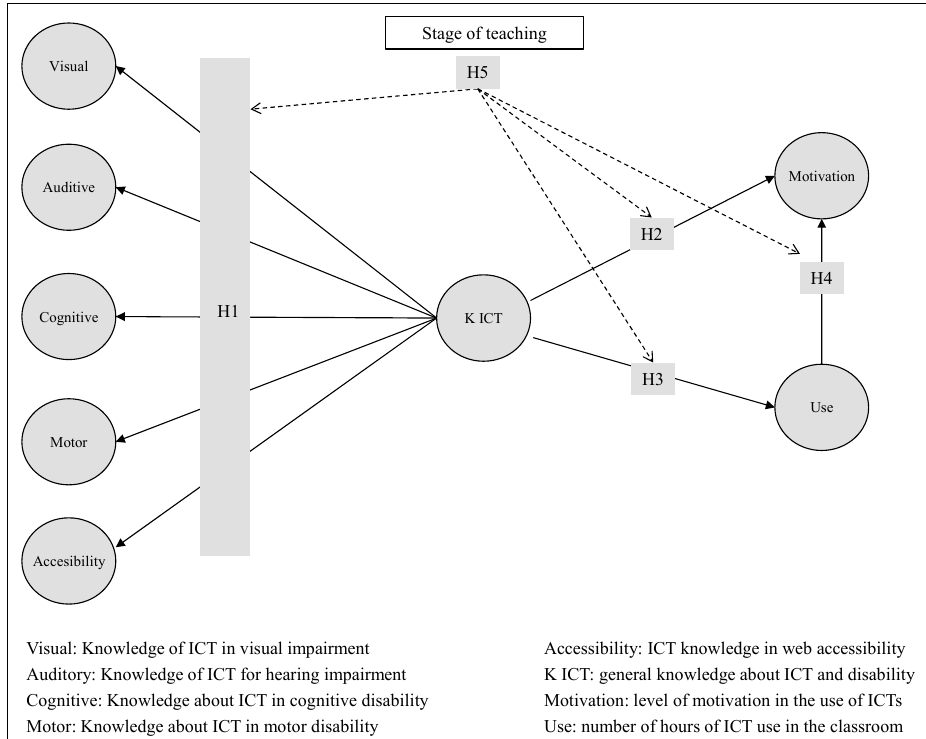
Figure 1. Proposed conceptual model.